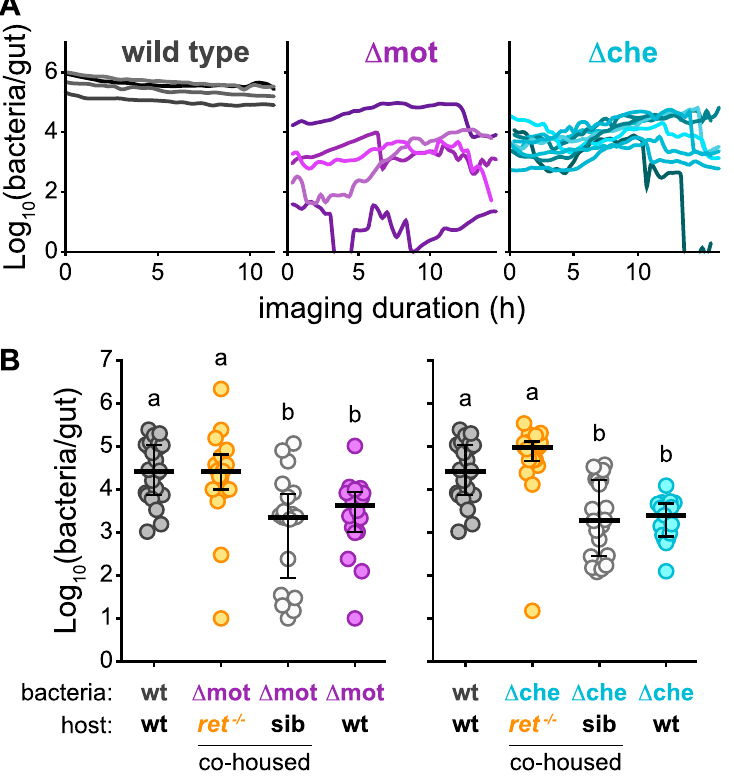
Fig 3. Swimming motility and chemotaxis promote persistence by enabling bacteria to counter intestinal flow and resist expulsion. (A) Image-based quantification of abundances over time for wt Vibrio , Δ mot, and Δ che. Lines represent individual populations in individual fish. (B) Cultivation-based quantification of abundances for Δ mot and Δ che in co-housed ret − / − mutant hosts and wt/heterozygous sib. Abundances of wt Vibrio , Δ mot, and Δ che in wt hosts (from Fig 1A, 72 hpi) are shown for comparison. Bars denote medians and interquartile ranges. Letters denote significant differences. p < 0.05, Kruskal-Wallis and Dunn’s multiple comparisons test. Underlying data are provided in S1 Data. hpi, hours post inoculation; sib, sibling controls; wt, wild